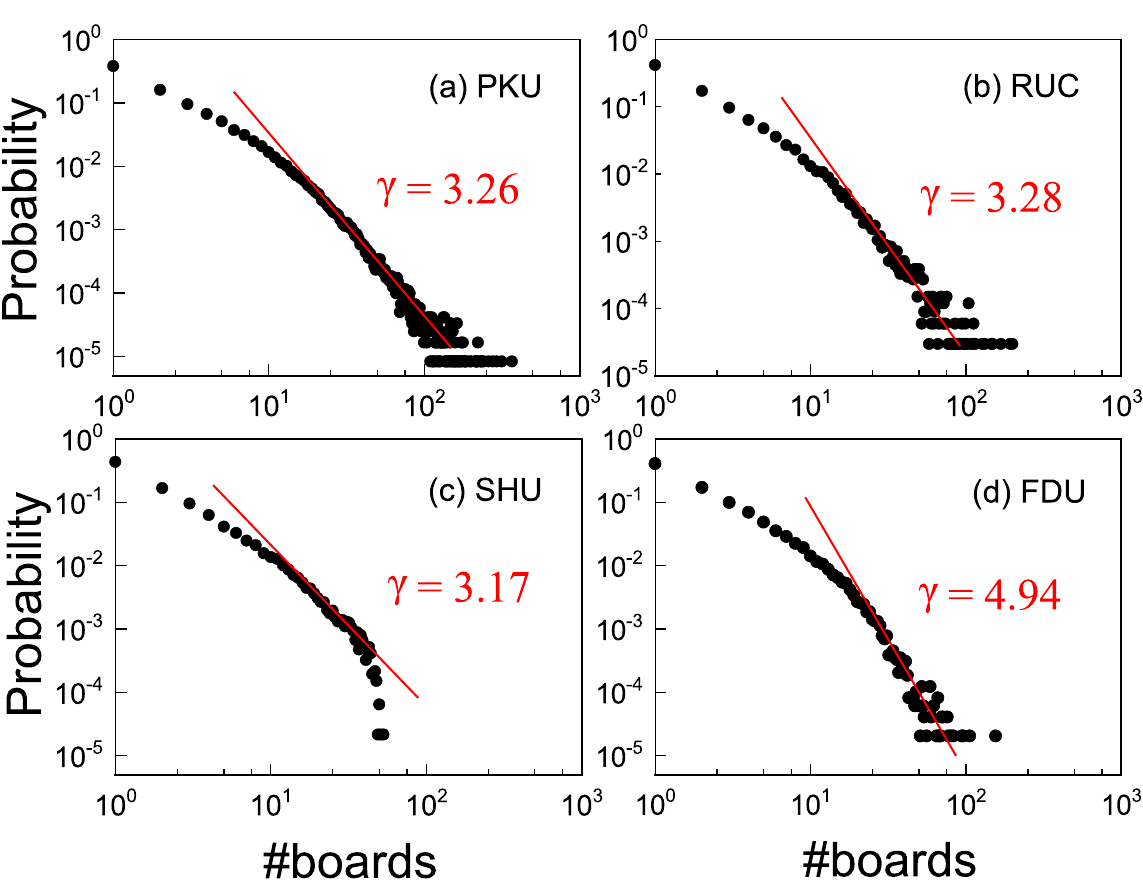
Fig 1. Probability density functions of active boards of users in their lifetime. The red lines are fitted power laws with different values of the exponent γ , which are obtained by the likelihood ratio statistical test [22, 23] with α < 0.05 for all universities.